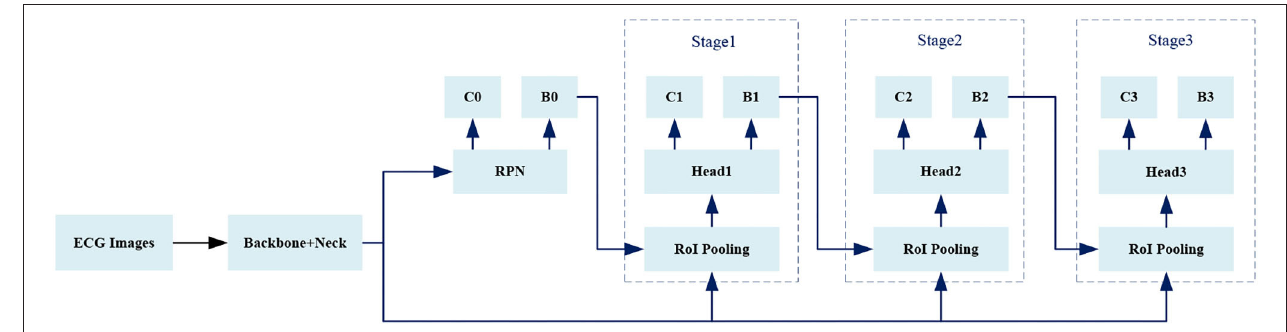
FIGURE 5 | The framework of object